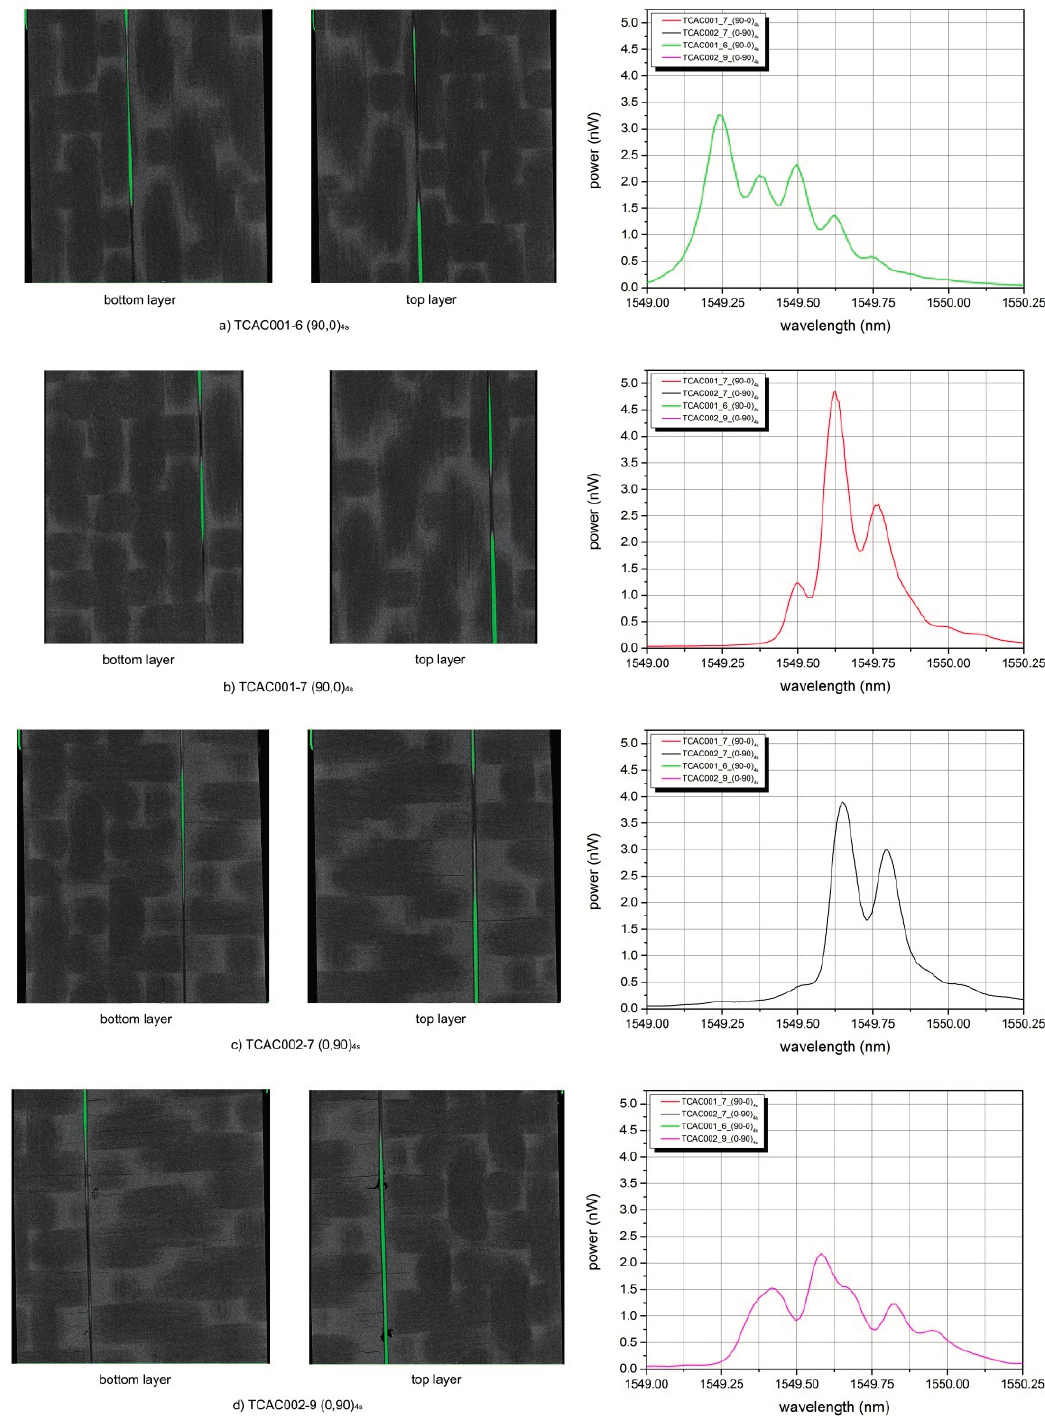
Figure 9. Sections along the stacking symmetry plane for four different carbon-PPS samples. Left: a section is taken from the 3D rendered volume of the reconstructed micro-CT along the woven-fabric layer just below the fibre optic; centre: the same section is taken just above the optical fibre on the upper woven-fabric layer; right: a spectrum of the optical fibre reflected signal is displayed. The first two cases ( a , b ) present the same stacking sequence [(90,0)] 4s ; while the last two cases ( c , d ) present the reversed situation [(0,90)] 4s . Different embedding results are revealed, therefore different reflected spectrum have to be